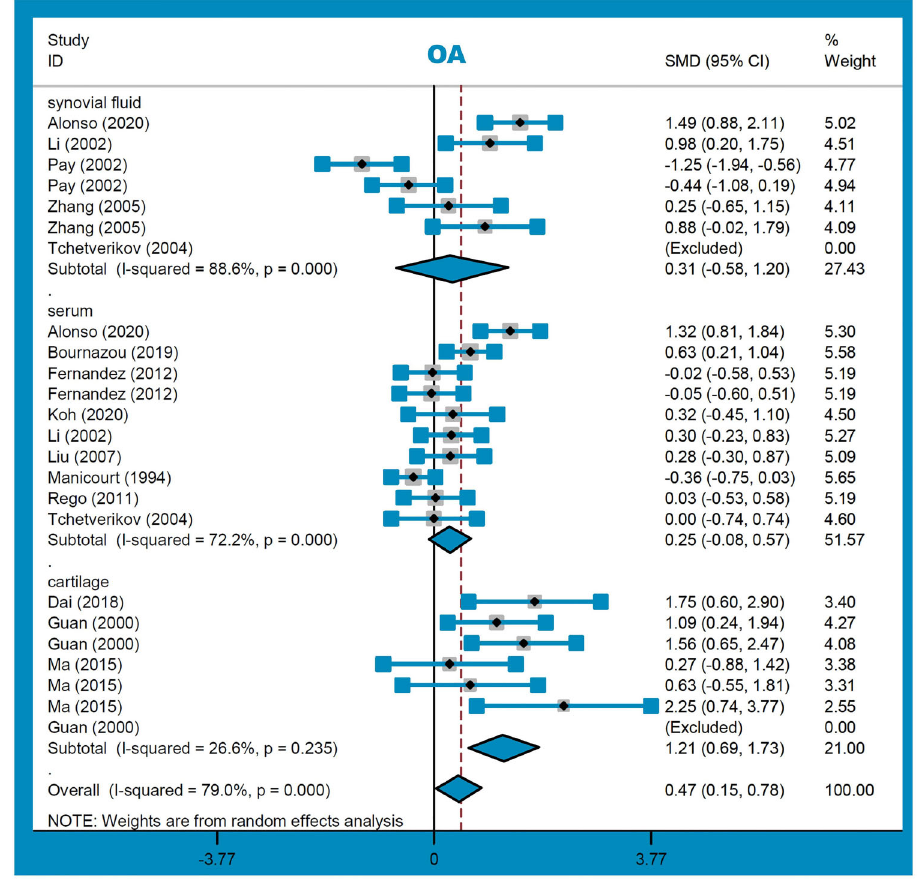
Figure 4. Subgroup analysis by sample source for osteoarthritis (OA) risk. See Supplementary Table S1 for reference